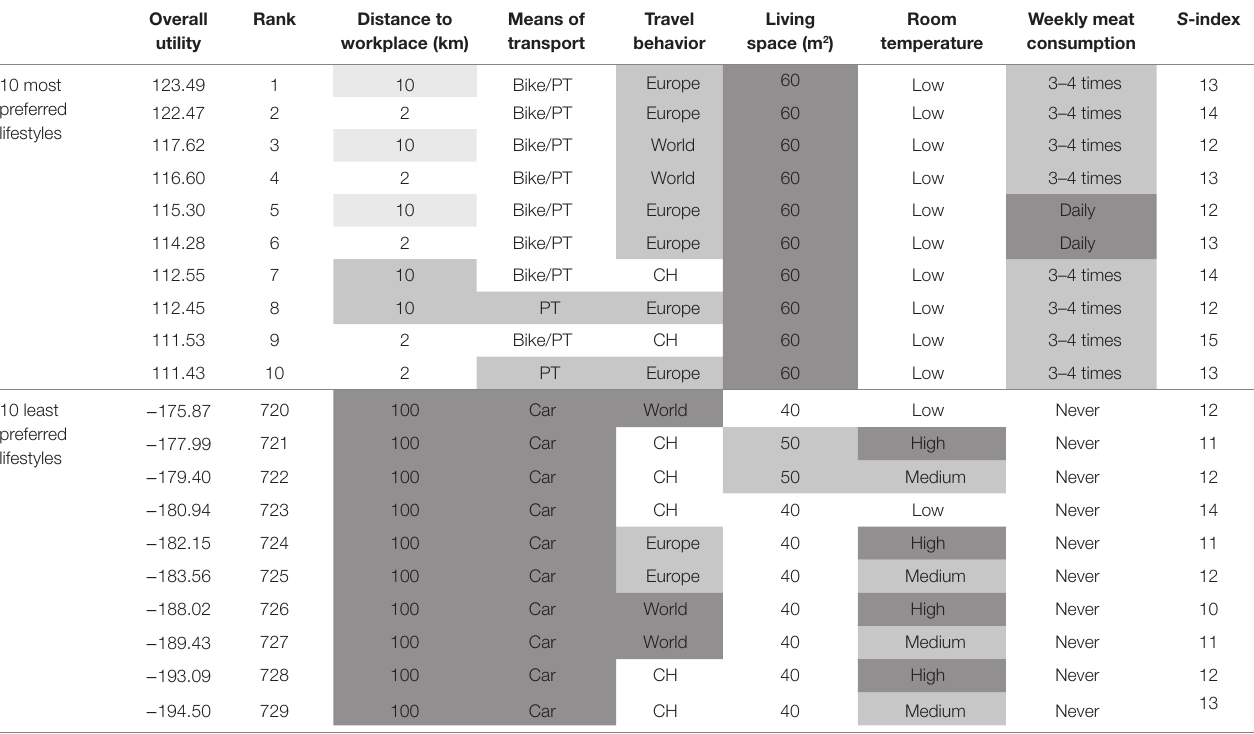
TaBle 5 | ranking of lifestyles (10 top-ranked and lowest-ranked lifestyles), ordered by overall utility.